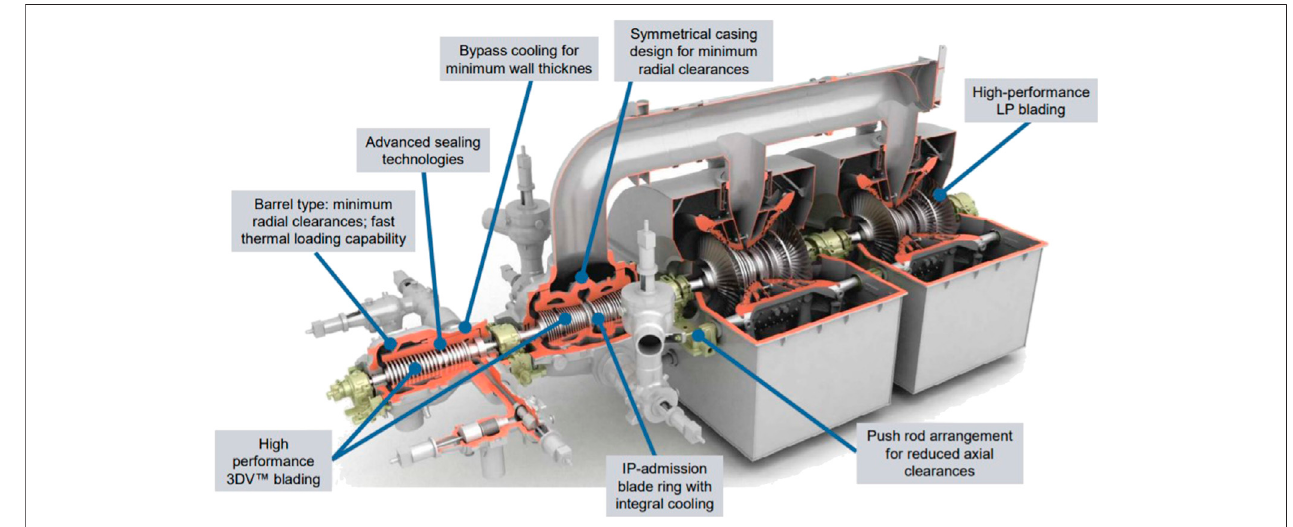
FIGURE 4 | Siemens SST5-6,000 steam turbine (from Cziesla et al.,